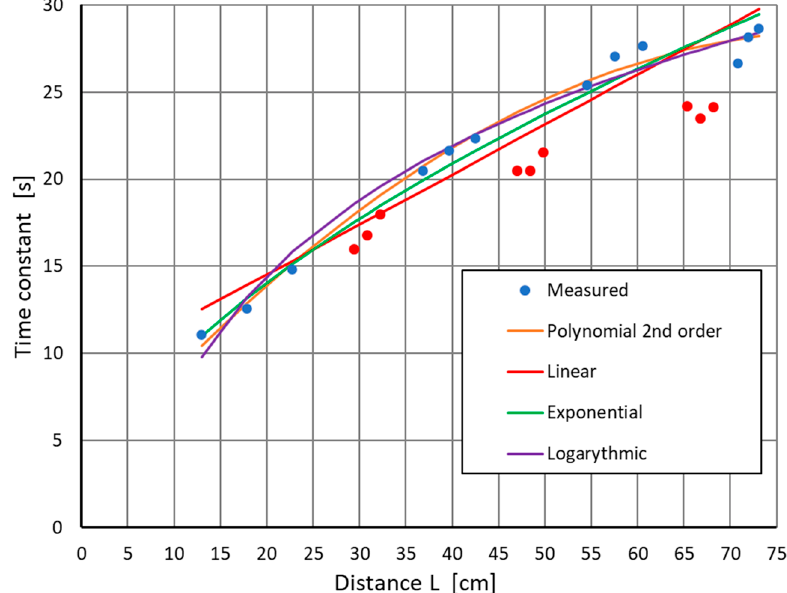
Figure 11. Changes in the time constant T depending on the distance from the input source L and the wall thickness of the tested object (blue points— T for d = 5 mm, red points— T for d = 3.5 mm, 4 mm, 4.5 mm).